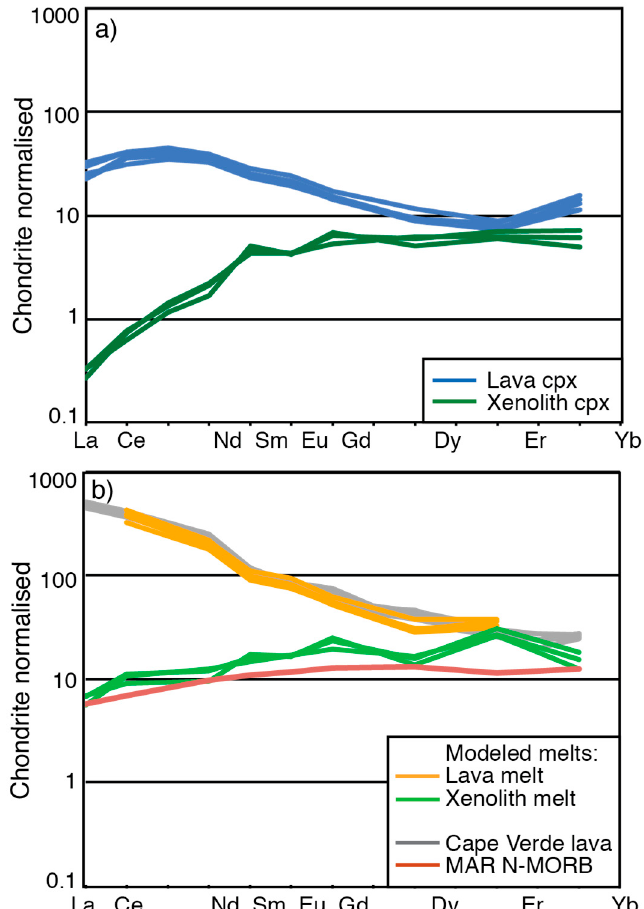
Figure 4. REE profiles for clinopyroxene from the xenoliths and host lavas. ( a ) The clinopyroxene in the lavas is slightly enriched in LREE whereas the xenoliths have clinopyroxene with depleted LREE. ( b ) Modelling has been undertaken to determine corresponding melts associated with clinopyroxene to compare with the Cape Verde OIB source and MORB [4,34]. Partition coefficients used in modelling are taken from [35] for the Cape Verde nephelinitic to phonolitic lavas and [36] for the gabbro xenoliths.